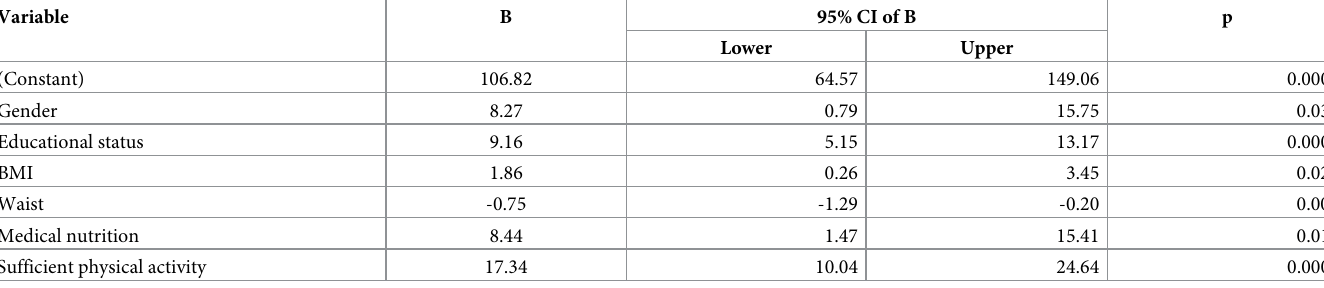
Table 5. Factors independently predictive of total DSMI score via multiple linear regression